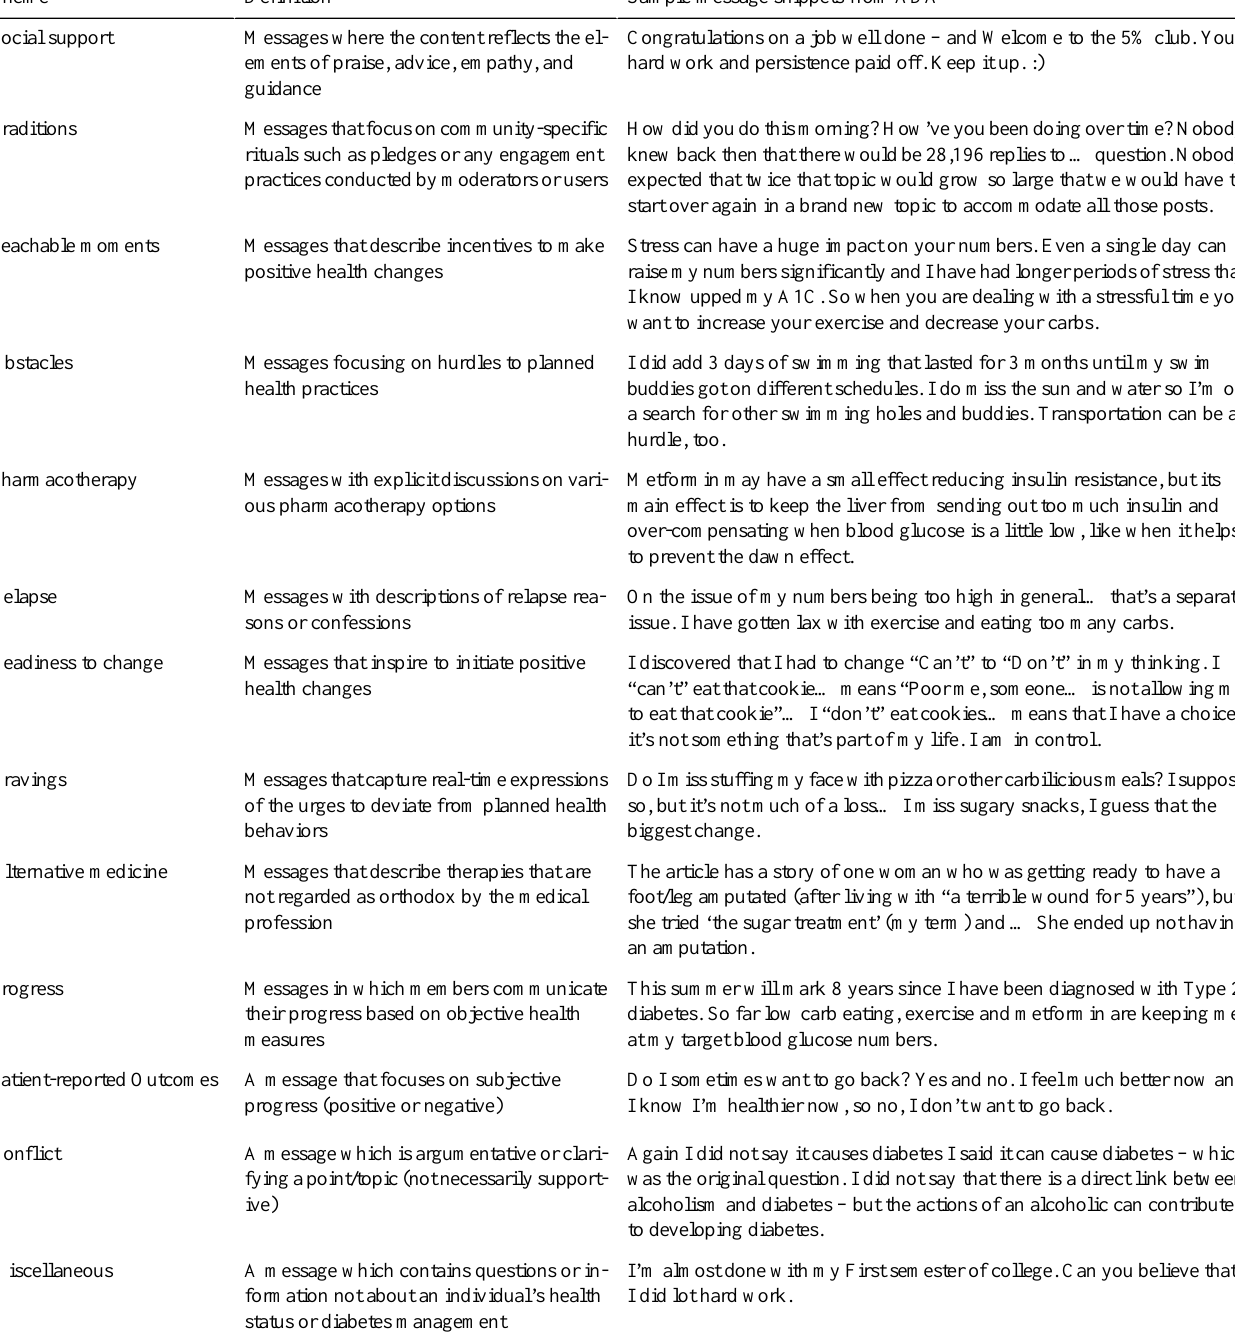
Table 1. Sample messages from the American Diabetes Association (ADA) mapped to the communication themes.